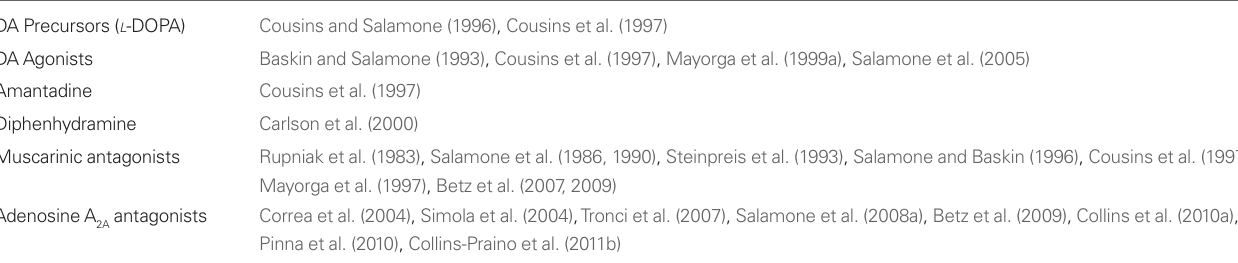
Table 2 | Antiparkinsonian drugs that reverse tremulous jaw